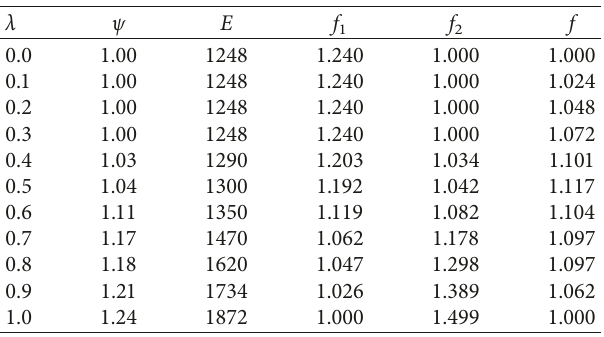
Table 6: Optimal signal timings for Test Network-2 for weighting factor λ �